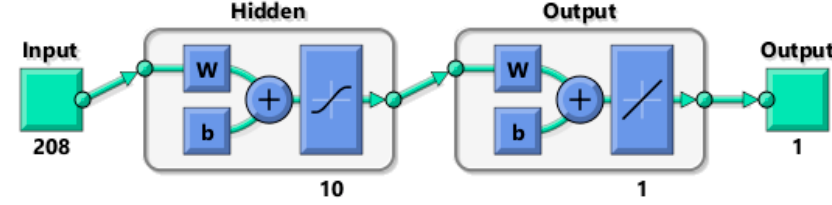
Figure 9. Model of a neural network generating single output image.